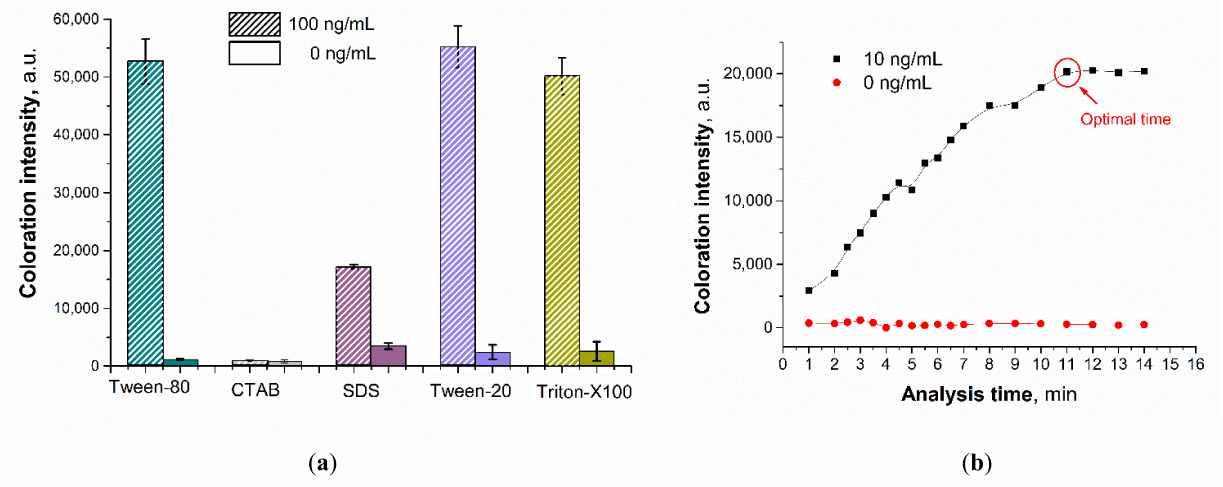
Figure 7. ( a ) Dependence of the color intensity in the test zone on the addition of various detergents to the running buffer. Error bars show the standard deviation from three replicate measurements; ( b ) time dependence of color in the test zone after application of a blank and running buffer containing 10 ng/mL Hg 2+